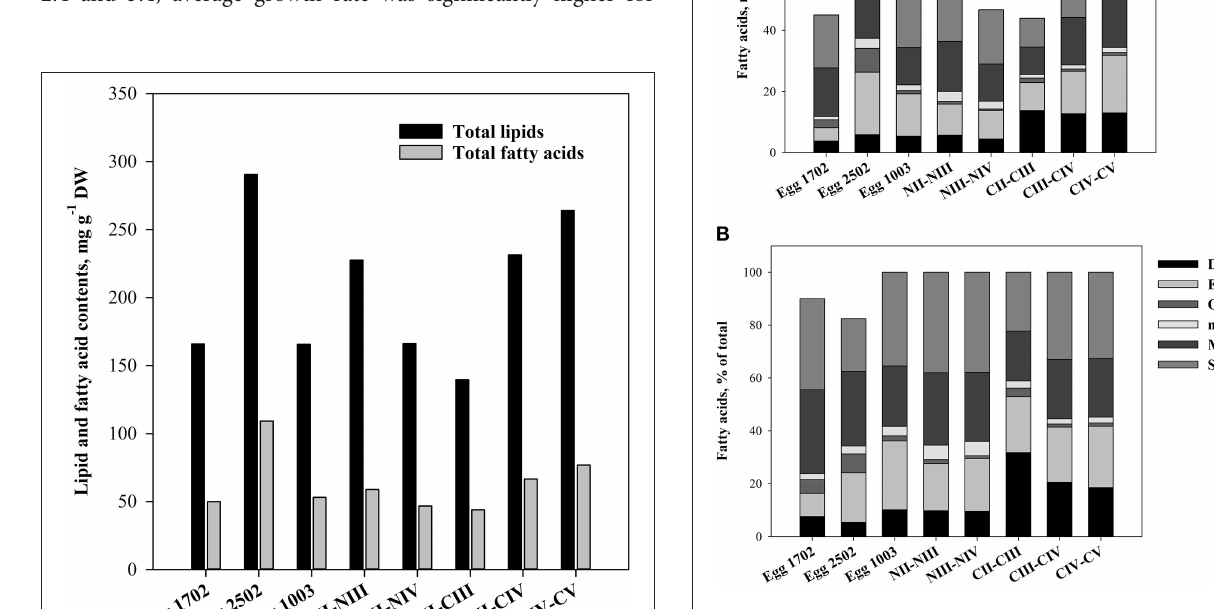
FIGURE 3 | Fatty acid profiles of eggs, nauplii, and copepodites of C. finmarchicus. (A) Quantitative fatty acid content (mg g − 1 DW). (B) Relative content (% of total fatty acids). The samples from 17/2 and from 25/2 contained a fraction of unknown fatty acids not included in the